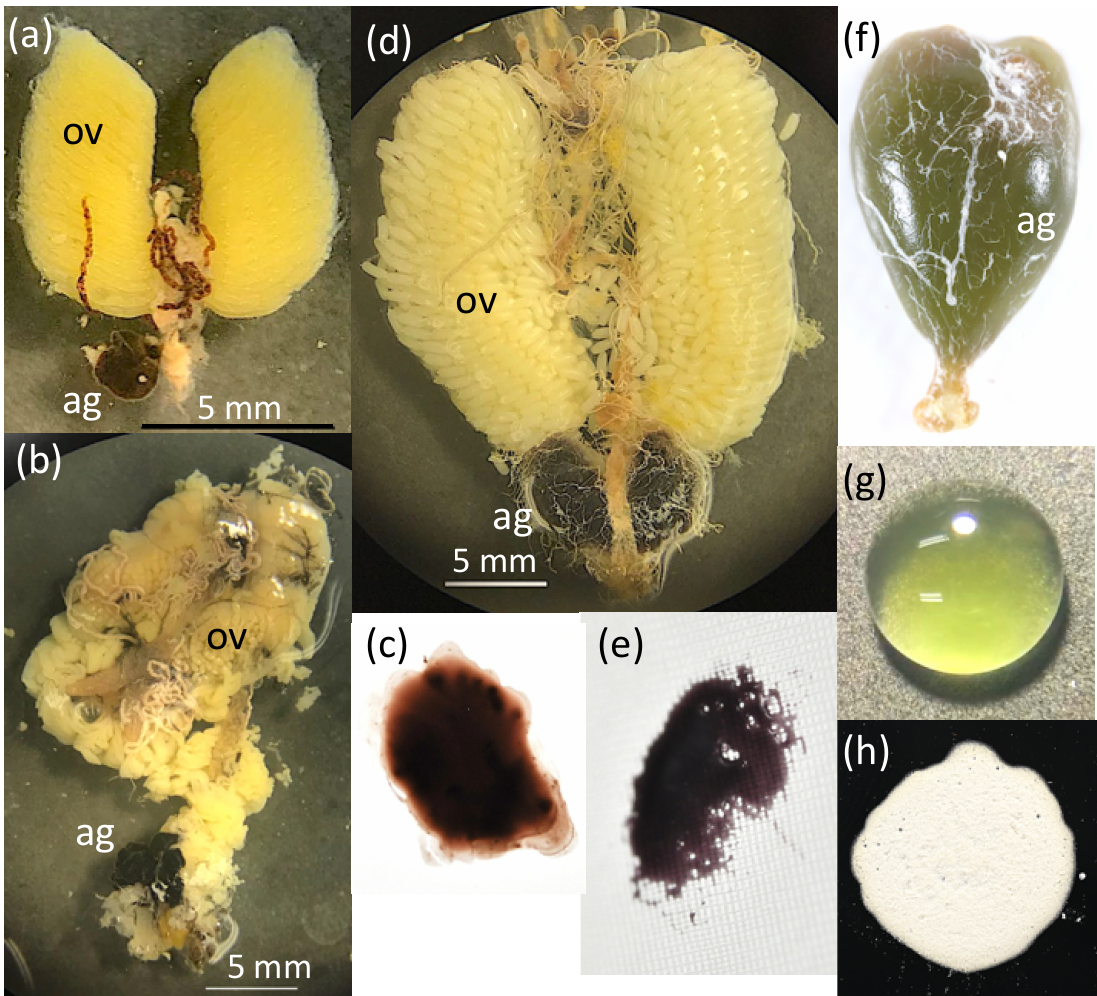
Figure 3. Megaloptera female accessory glands (ag) and ovaries (ov). ( a ) Sialis melania , in situ; ( b , c ) Parachauliodes continentalis , in situ, and accessory gland substance one day after secretion; ( d , e ) Protohermes grandis , in situ, and accessory gland substance one day after secretion; ( f–h ) Neoneuromus ignobilis : ( f ) dissected accessory gland, ( g ) pale green color of the accessory gland substance just after excretion, ( h ) accessory gland substance dried to a hardened white powder.